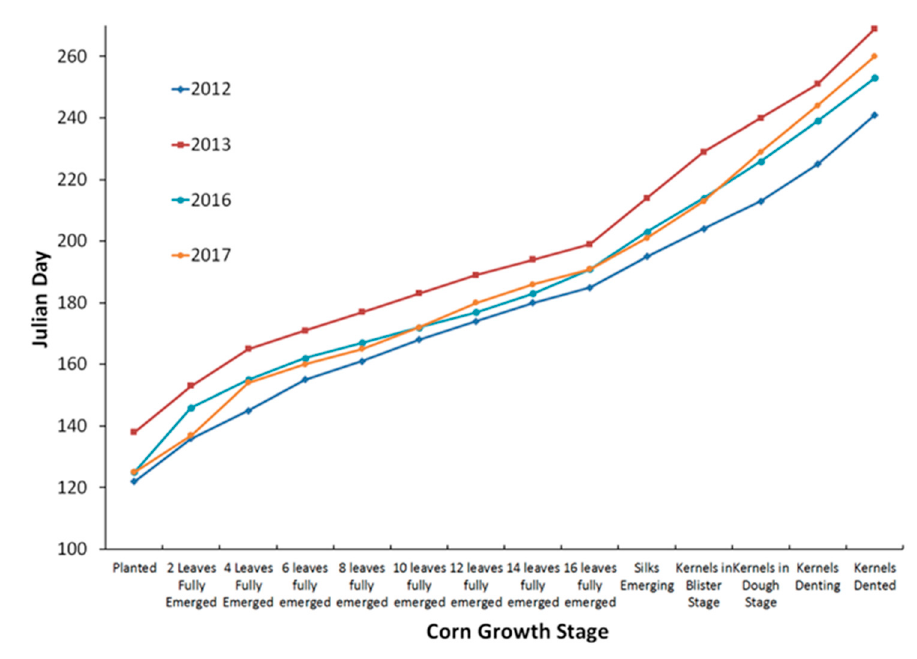
Figure 9. Estimated corn growth stages comparison in 2012, 2013, 2016, and 2017.